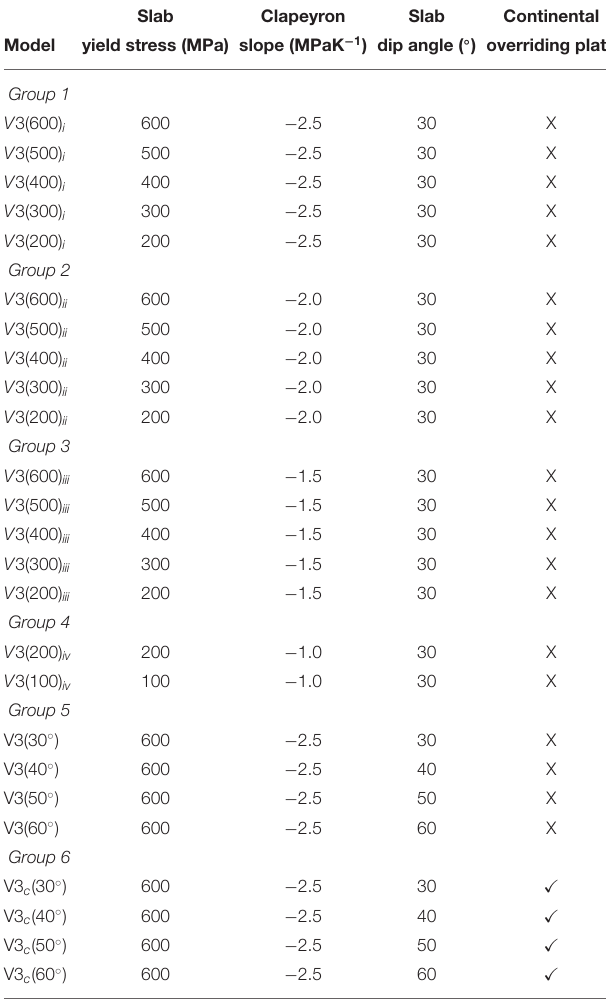
TABLE 2 | Model variations reflecting the different initial